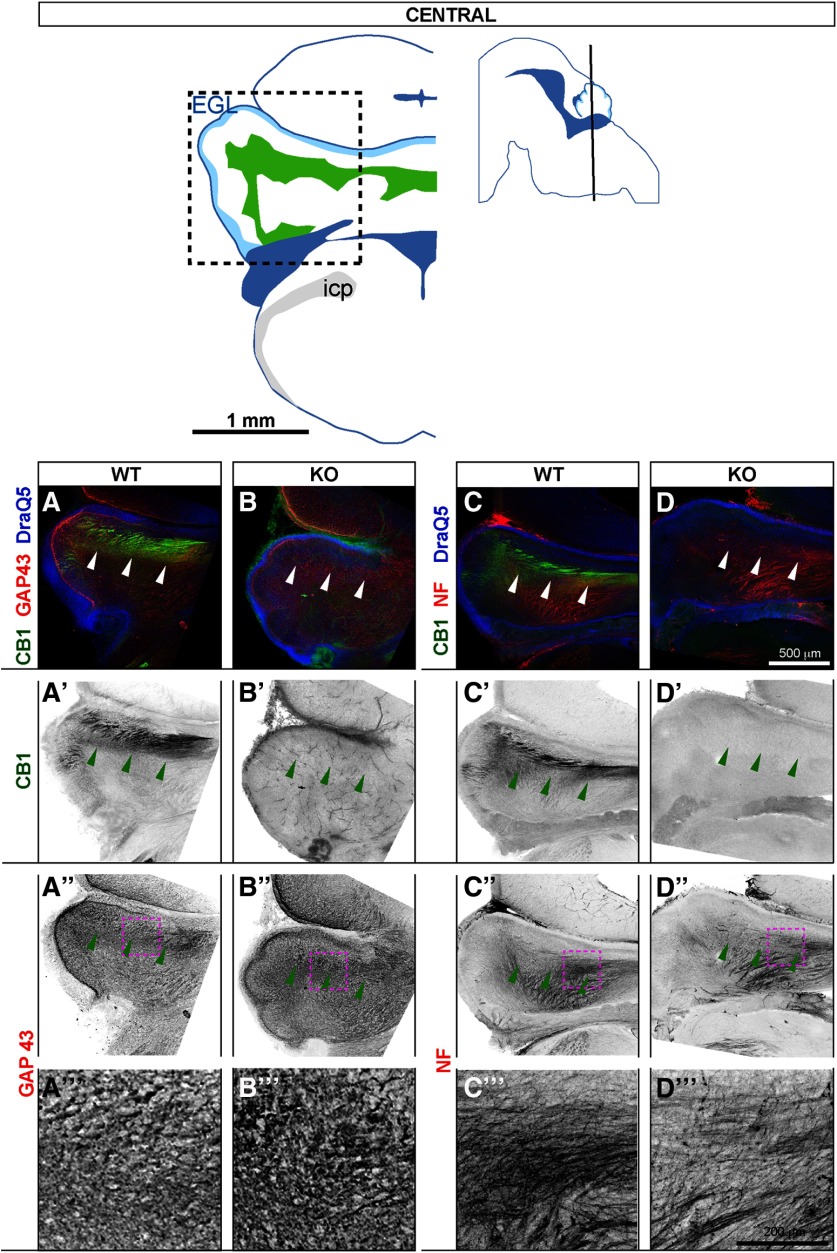
At E17.5, CB1 is expressed in the developing white matter tracts (pWM), which show increased GAP43 accumulation and altered axon distribution in CB1 KOs. Coronal sections at E17.5 through central cerebellar zone. Top row, left: outlines of a representative coronal section showing anatomic landmarks. Regions imaged in (A–D’’’) are indicated by dotted square. Top row, right: black line through sagittal diagram shows plane of sectioning. Anatomical locations are adapted from Paxinos et al. (2007). In WTs, CB1 co-localizes with axonal markers GAP43 (A–A’’’) and NF (C–C’’’). In KO littermates (B–B’’’) and (D–D’’’) CB1 staining is absent, density of GAP43 staining within pWM is increased (B”, B’’’), and distribution of NF-positive axons (D”, D’’’) is abnormal. Panels in the bottom row (A’’’–D’’’) show zoomed-in views from regions indicated by maroon dotted outlines in A”–D”.